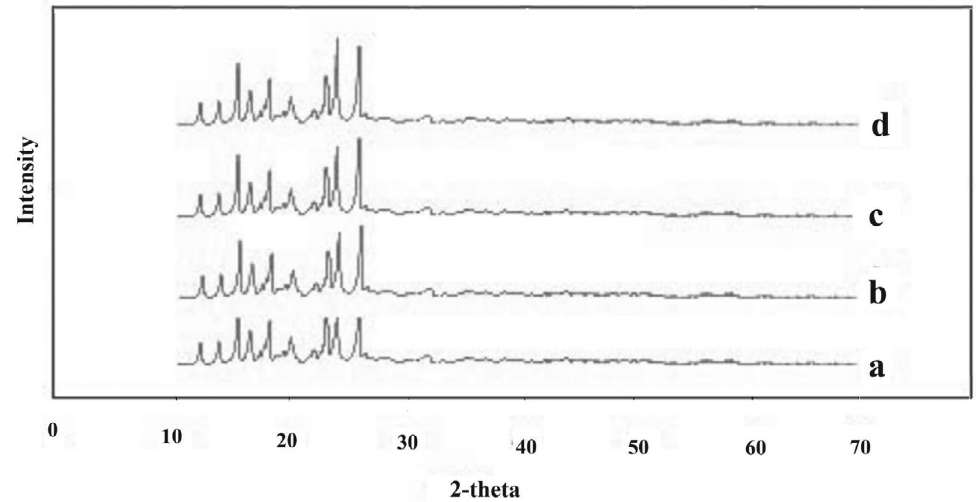
Figure 6. XRPD of COAM 1 after a) 0 days, b) 30 days, c) 60 days and d) 90 days at accelerated stability